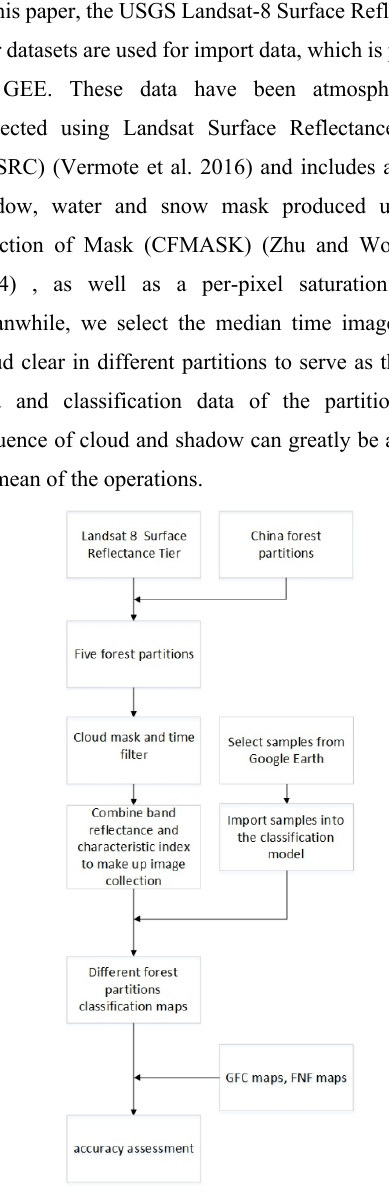
Figure 2. China forest cover detection